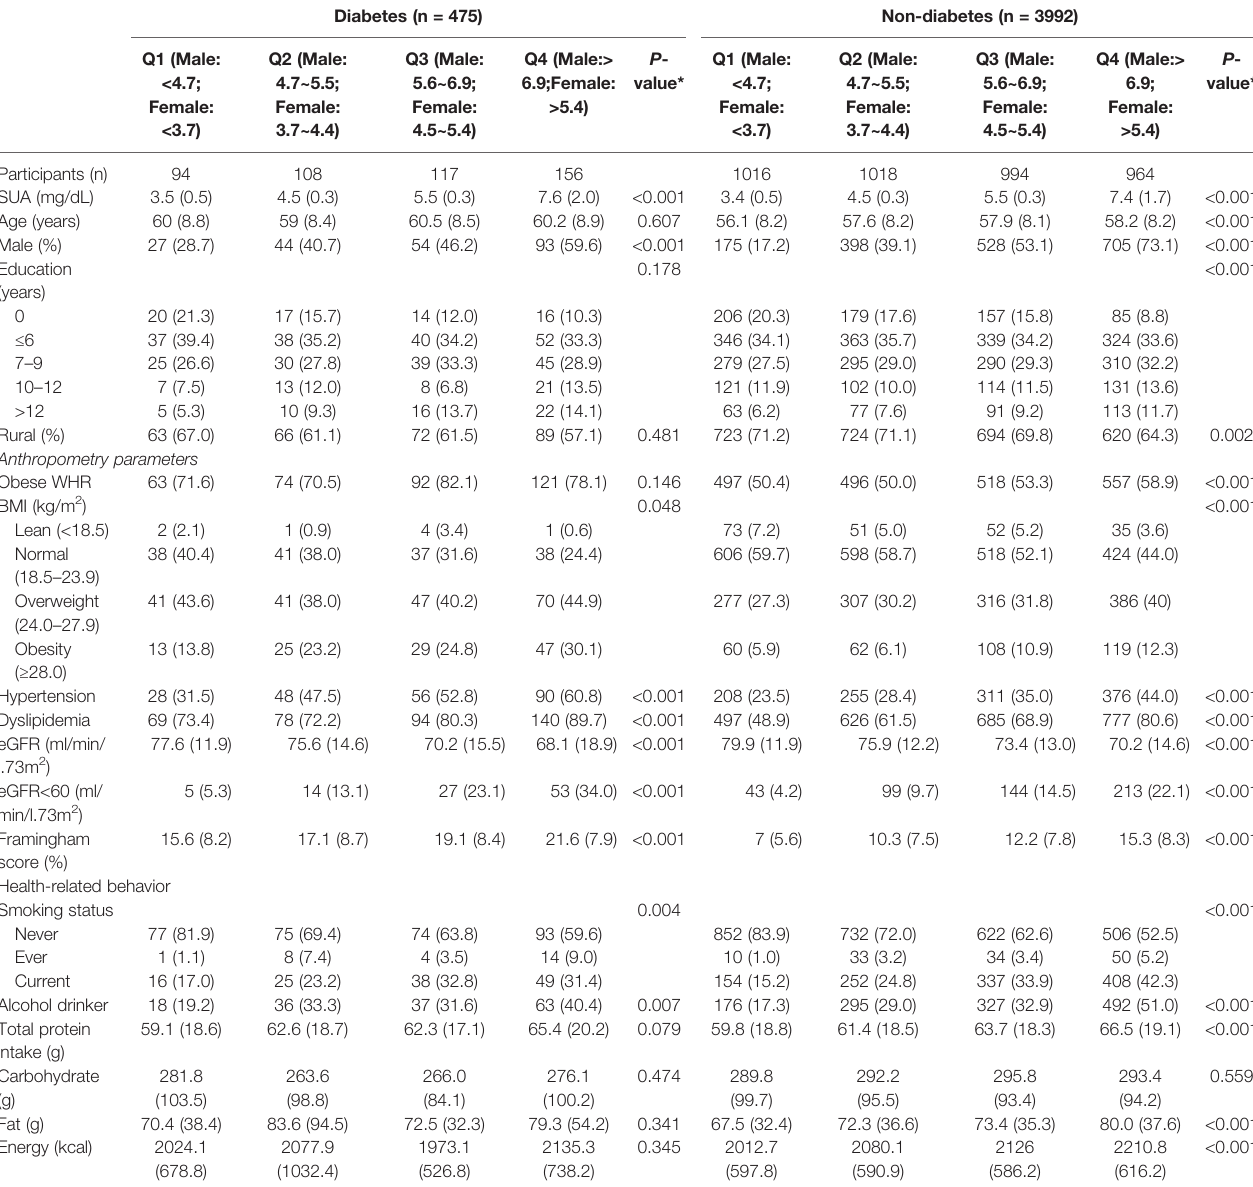
TABLE 1 | Baseline characteristics of the participants and SUA quartiles among individuals with and without diabetes in CHNS Cohort. Diabetes (n = 475) Non-diabetes (n =